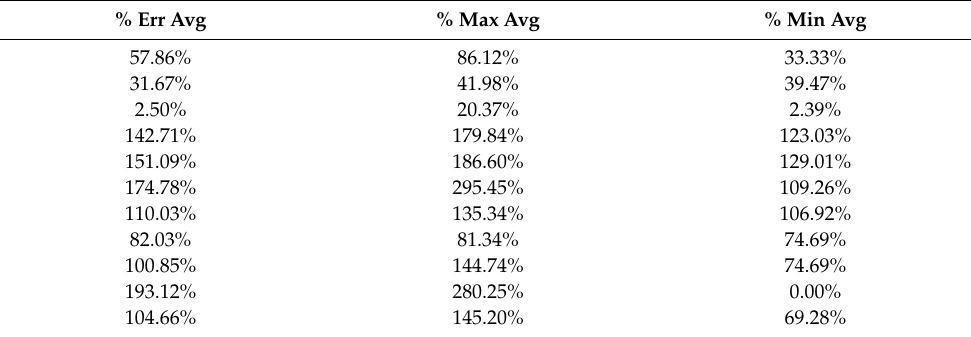
Table A135. Set 2, trials 31–40 data (all 0.5 PR values).